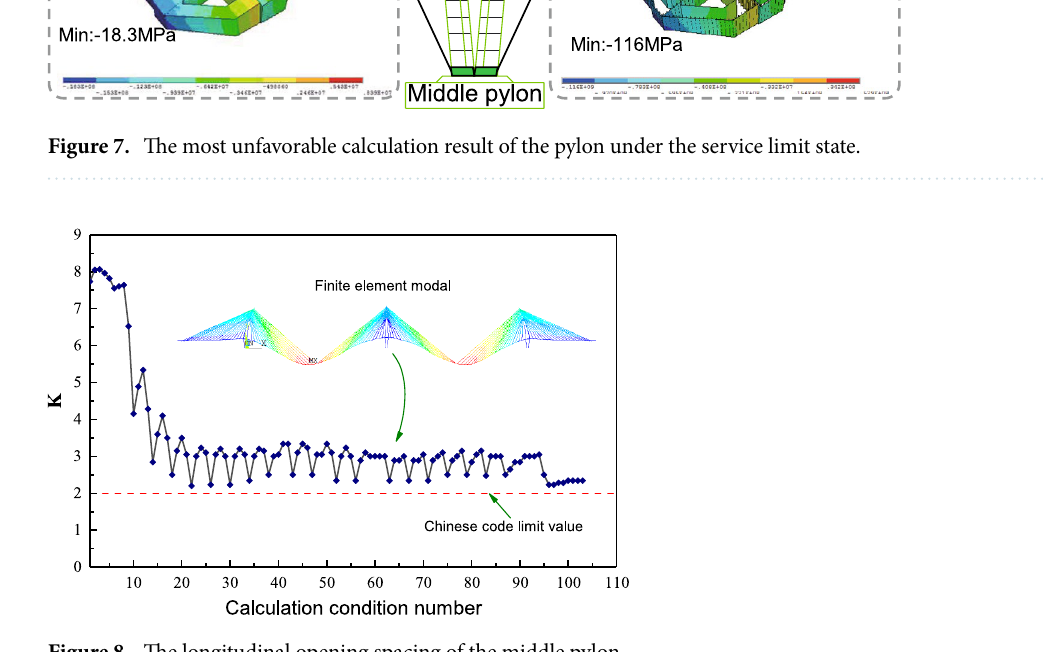
Figure 8. The longitudinal opening spacing of the middle